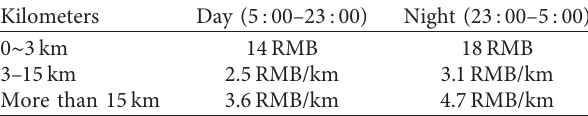
Table 2: Taxi charging standard in a city.